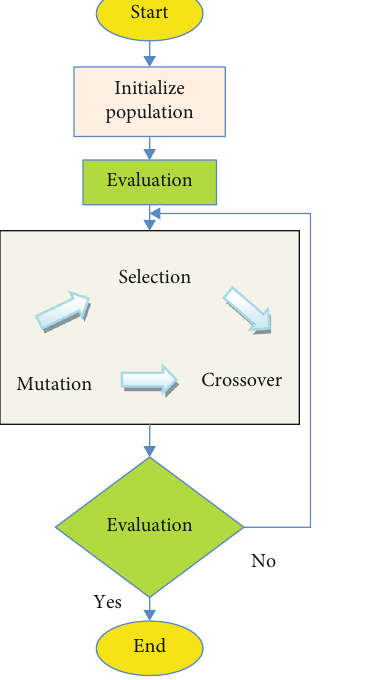
Figure 6: Flow chart of the GA algorithm.